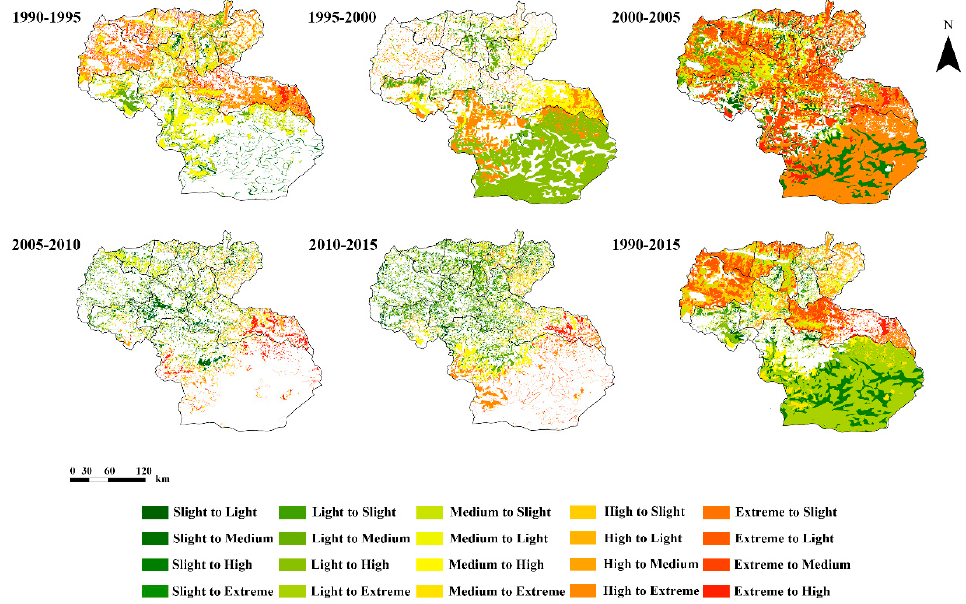
Figure 5. EVI Tupu changes of Shannan in 1990–2015.